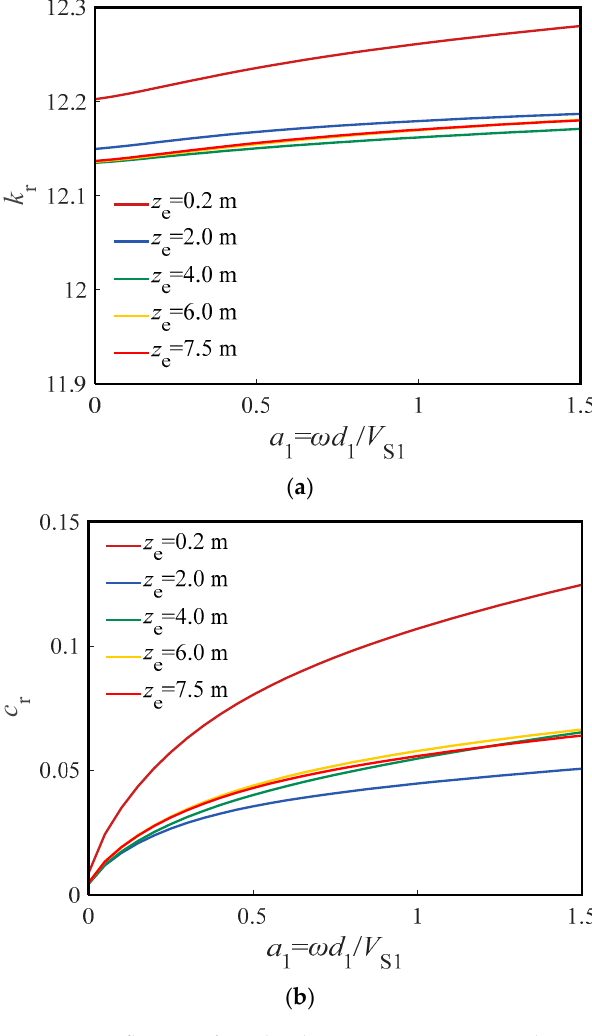
Figure 11. Influence of weak pile segment position on the RDI of pile head. ( a ) Stiffness factor of RDI and ( b ) damping factor of RDI.